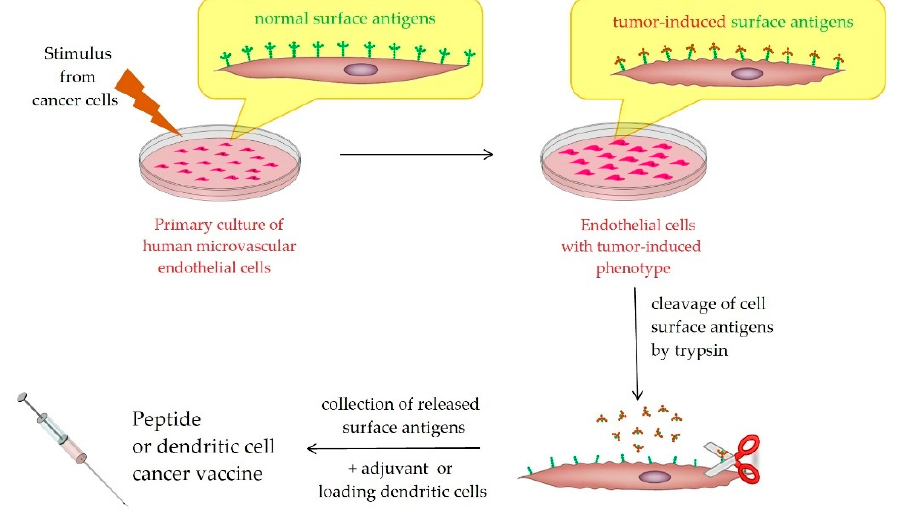
Figure 2. Schematic representation of antiangiogenic SANTAVAC production for peptide or dendritic cell-based vaccine. Adapted from [40].